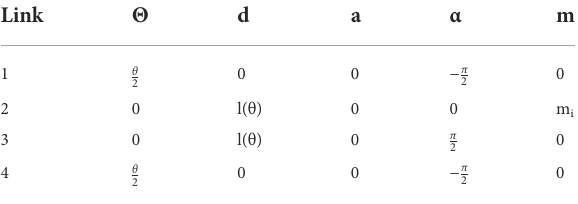
TABLE 1 Classic DH parameters θ , d, a, α and mass m for one actuator.